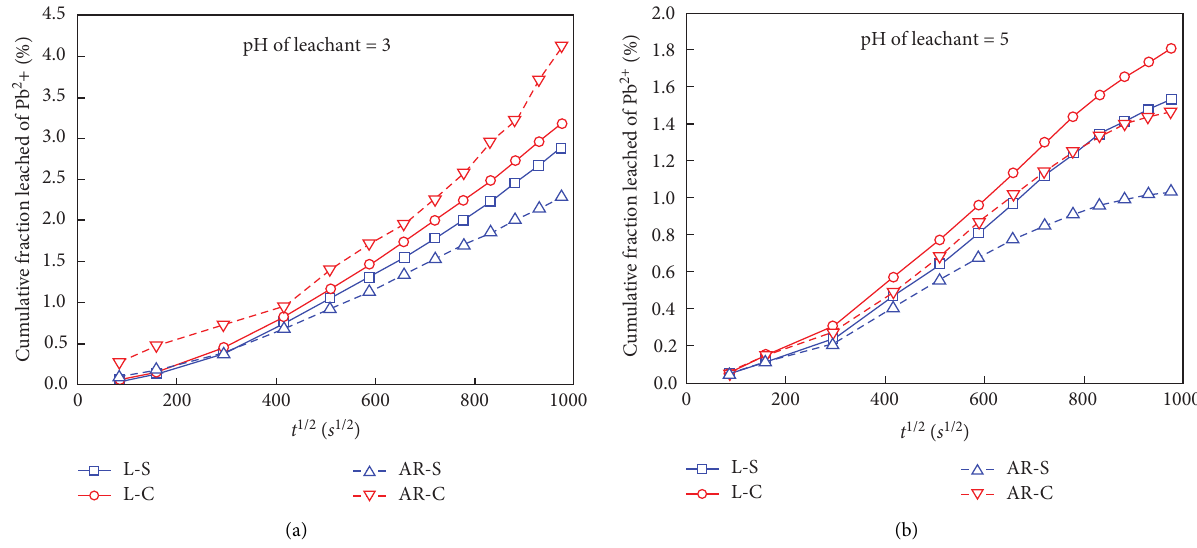
Figure 7: Evolution of cumulative fraction leached (CFL) of Pb 2+ with time ( s 1/2 ): (a) leachant pH of 3 and (b) leachant pH of